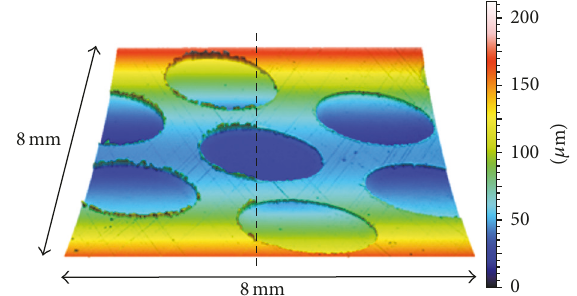
Figure 1: Illustration of the removal of the textures edge defects. The dotted line represents the reversal zone of the oil control ring; to the right of this line, the textures were removed in an initial experimental step.